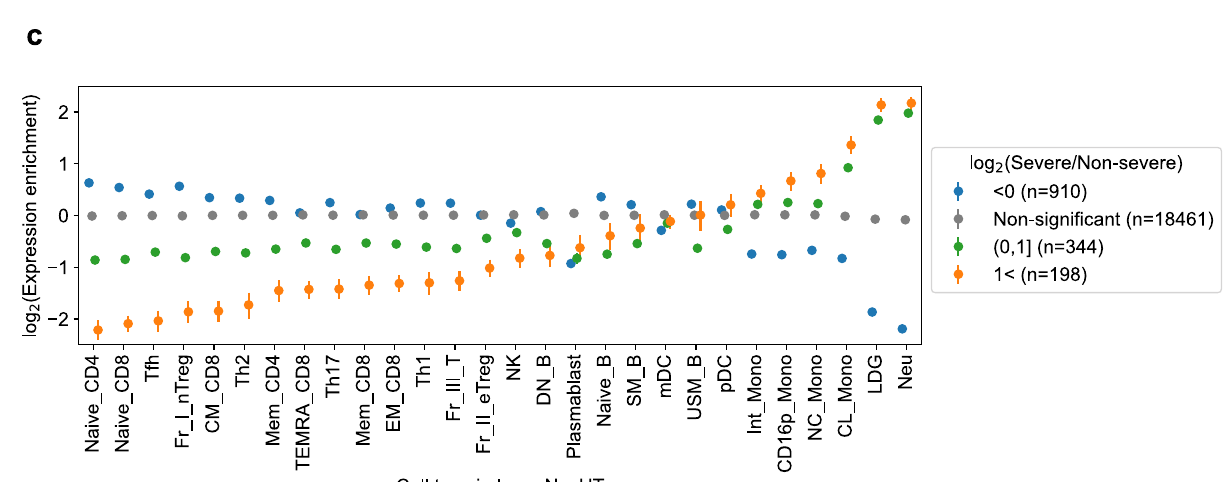
Fig. 6 | Transcriptional interpretation of COVID-19 susceptibility. a Volcano plot showing the difference of the RNA expression level between severe and non- severe COVID-19 cases ( x axis, log 2 (severe/non-severe)), and the statistical sig- ni fi cance (likelihood ratio test p value, y axis). Color shows the log 10 (count per